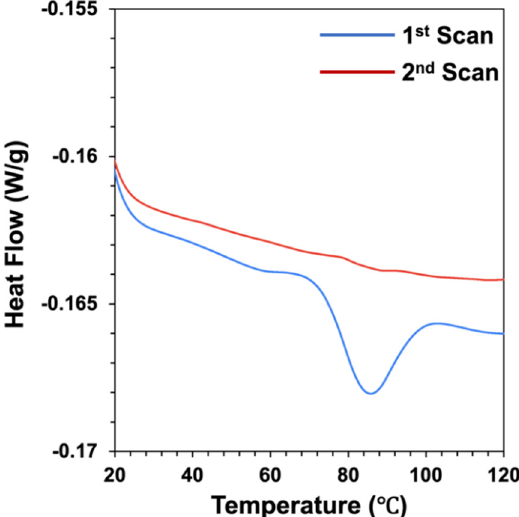
Figure 1. Heat flow versus temperature profiles of pea protein (20 wt%) when heated twice from 10 to 120 °C at 3 °C min − 1 . The endothermic peak observed during the first scan suggests the proteins were originally in the native state, whereas the lack of peaks in the second scan suggests that they were irreversibly denatured by